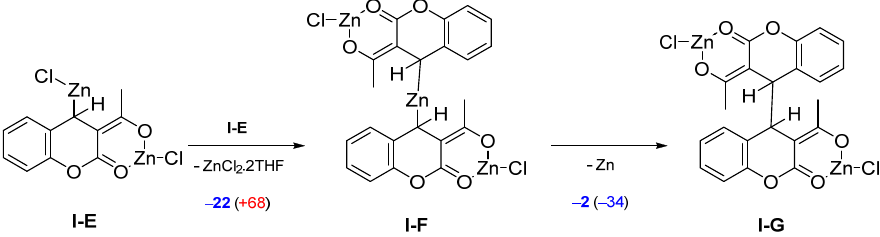
Scheme 7. Schematic representation of the ionic reaction mechanism. The Enthalpies (Free energies given in parenthesis) for the formation of the intermediates are presented in